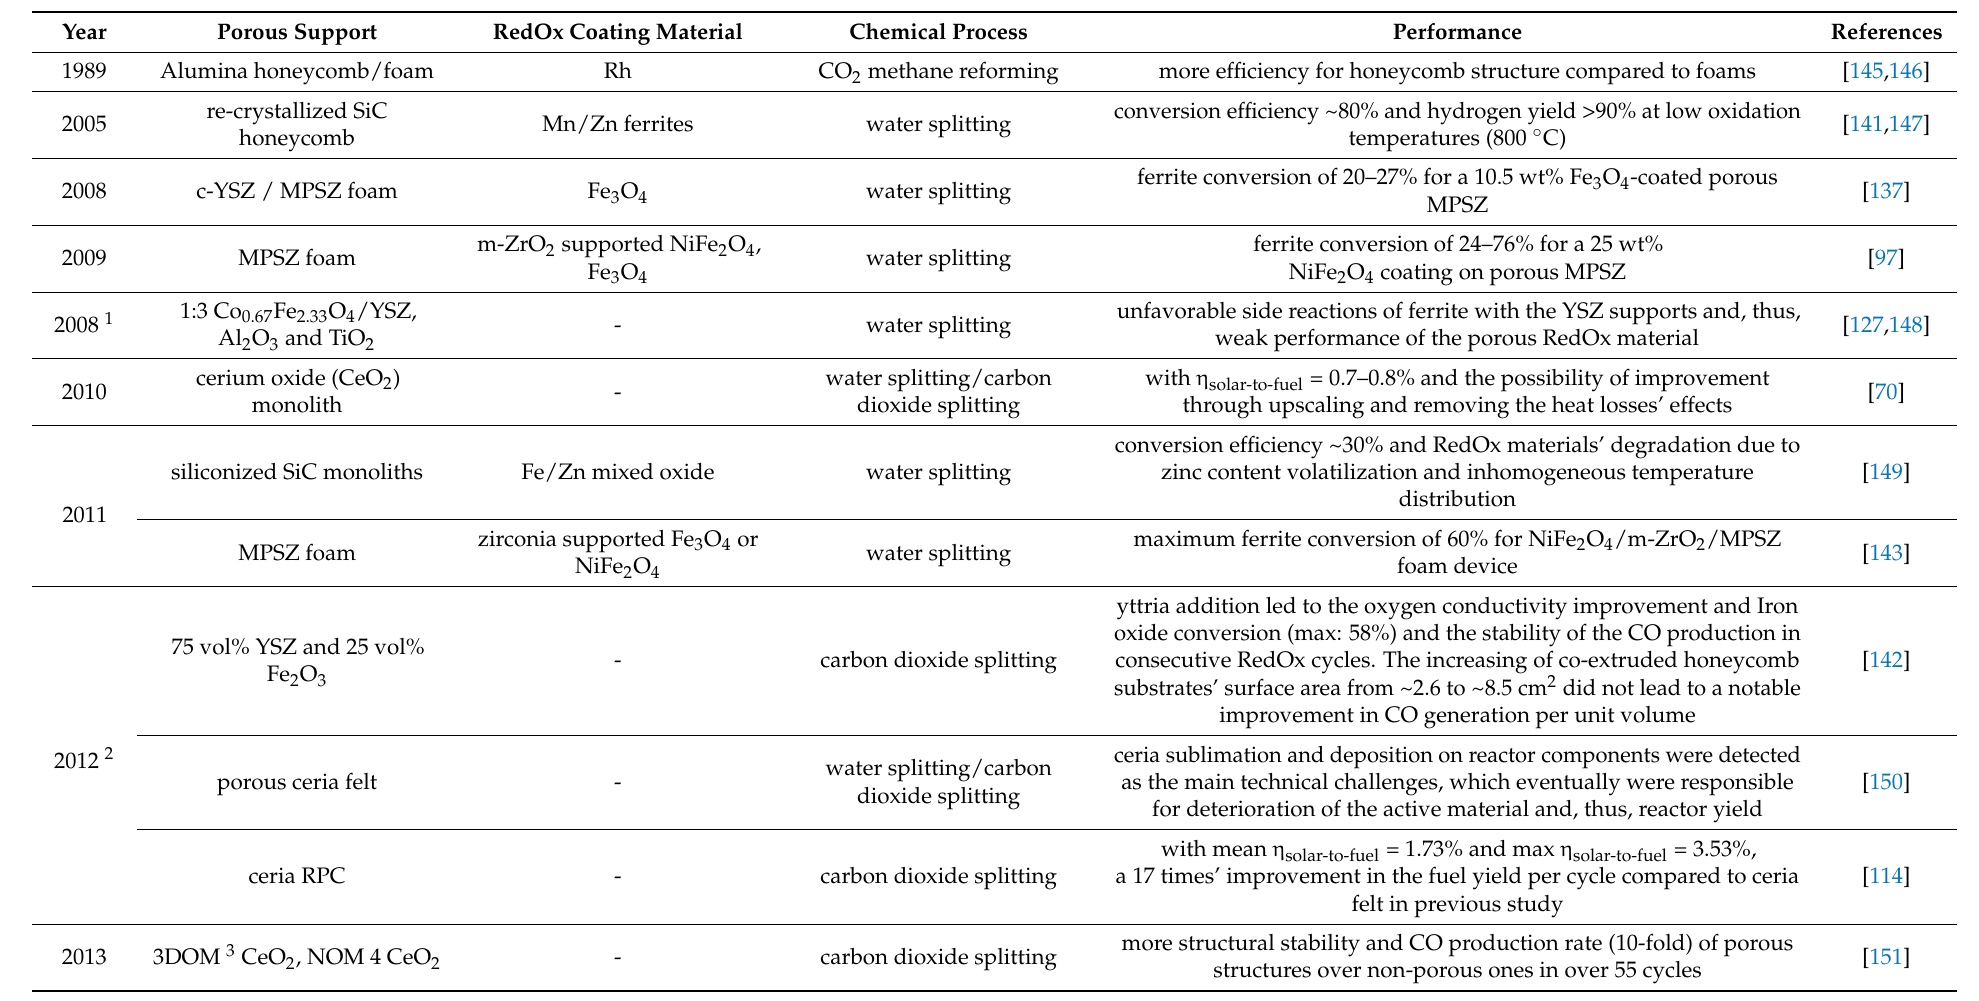
Table 2. List of research items on the application of porous materials for solar thermochemical conversion